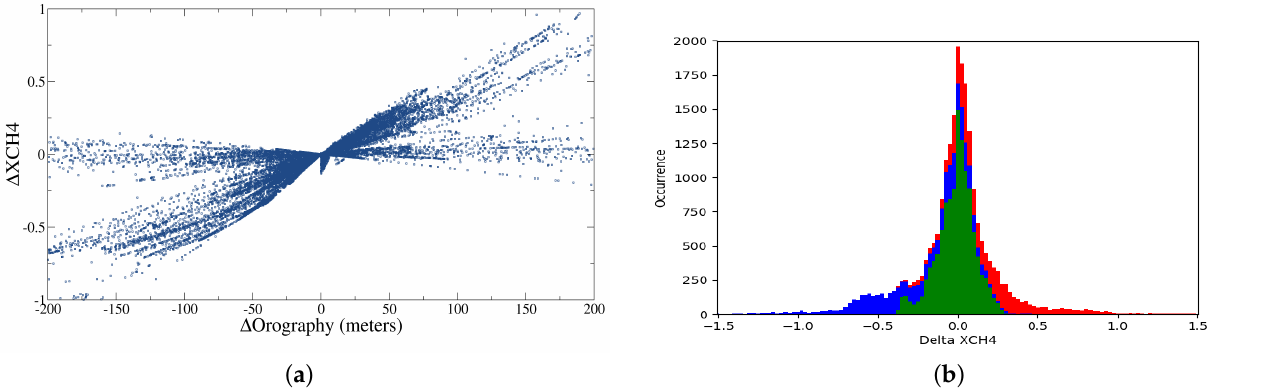
Figure 7. Distribution of the differences between the mole fraction of methane to dry air averaged over the atmospheric column retrieved using the “standard gradient” in LIDSIM and APACHE in PROLID and the same quantity retrieved using APACHE in LIDSIM and the “standard gradient” in PROLID. ( a ) Each point corresponds to such a difference distributed according to the difference in topography between the meteorological model and the DEM limited for the figure to ± 200 m. ( b ) The histogram of these differences (with a sampling of 0.025 ppb): in green if the topography difference is between − 50 m and 50 m, in red if it is greater than 50 m and in blue if it is less than − 50 m. We have eliminated the points with a difference in topography between − 10 m and 10 m for reasons of readability, which represents 72,333 points out of 95,360 that are with differences in methane retrieval of less than 0.1